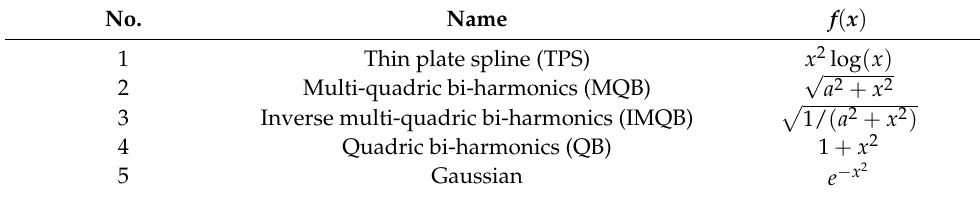
Table 2. RBFs with global